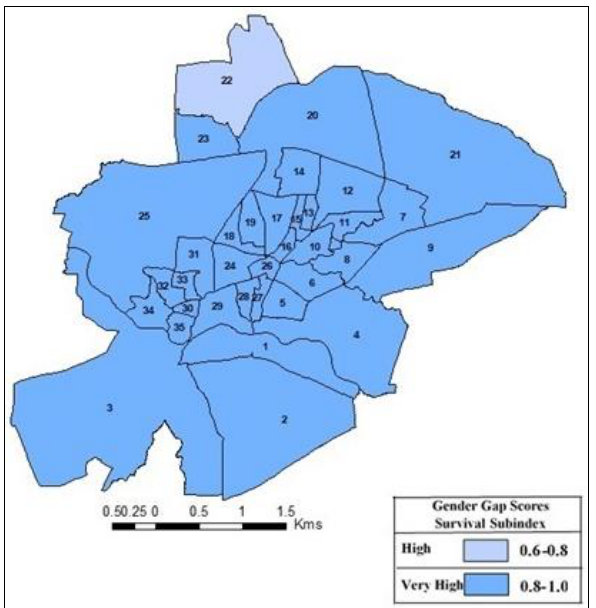
Fig. 4. Scores on the Social Subindex, of the Gender Gap Index, Sehore M.C., 2011